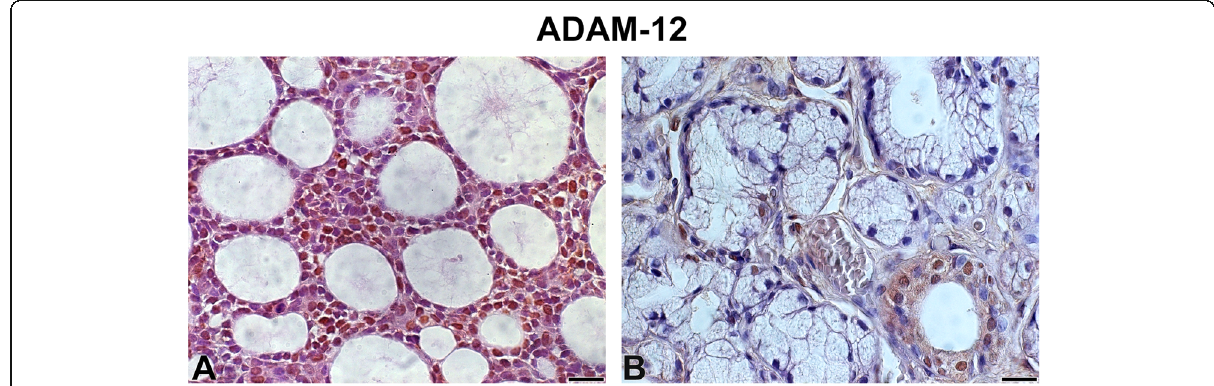
Fig. 3 ADAM-12 Legend: Immunostaining of a disintegrin and metalloproteinase 12 in adenoid cystic carcinoma ( a ) and normal-looking salivary gland ( b ). Immunoperoxidase. Scale bar: 20 μ